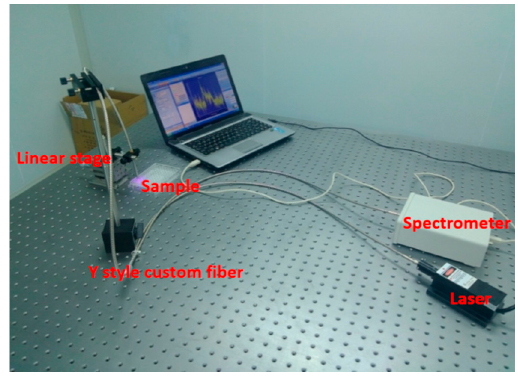
Figure 8. The fluorescence spectrometry system.